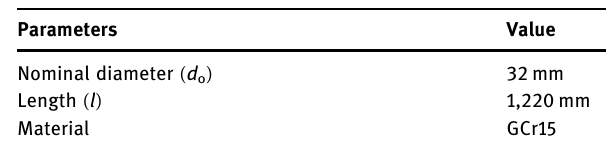
Table 1: Ball screw parameters